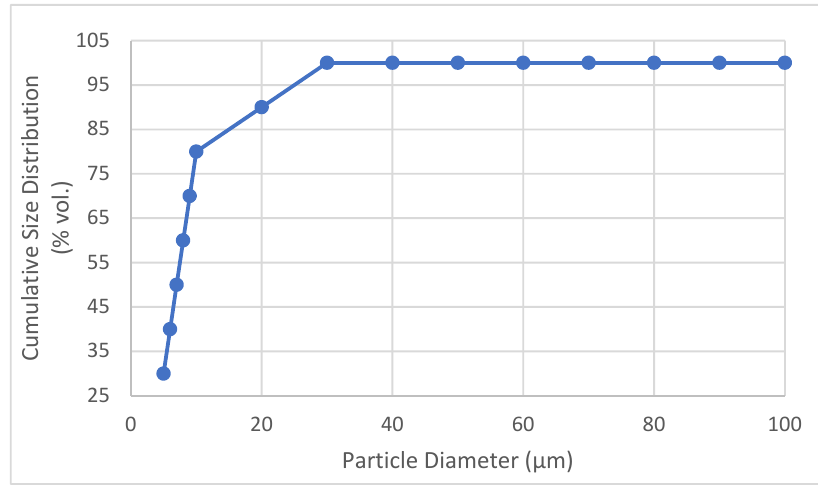
Figure 10. Size range of chalk powder particles .